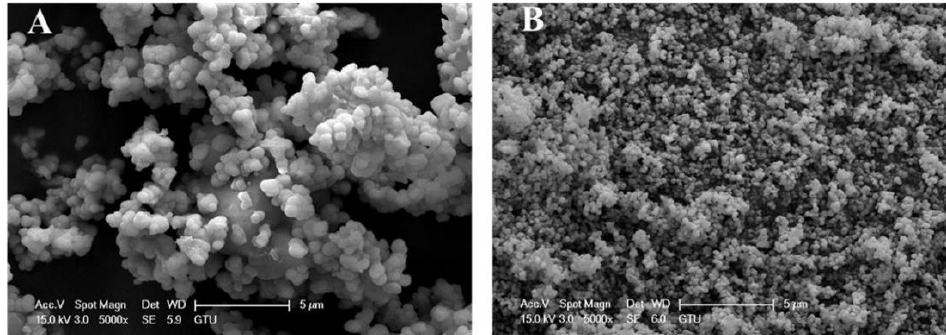
Figure 12. SEM images of TiO 2 NPs for ( A ) at 1 h and ( B ) at 5 h [167].